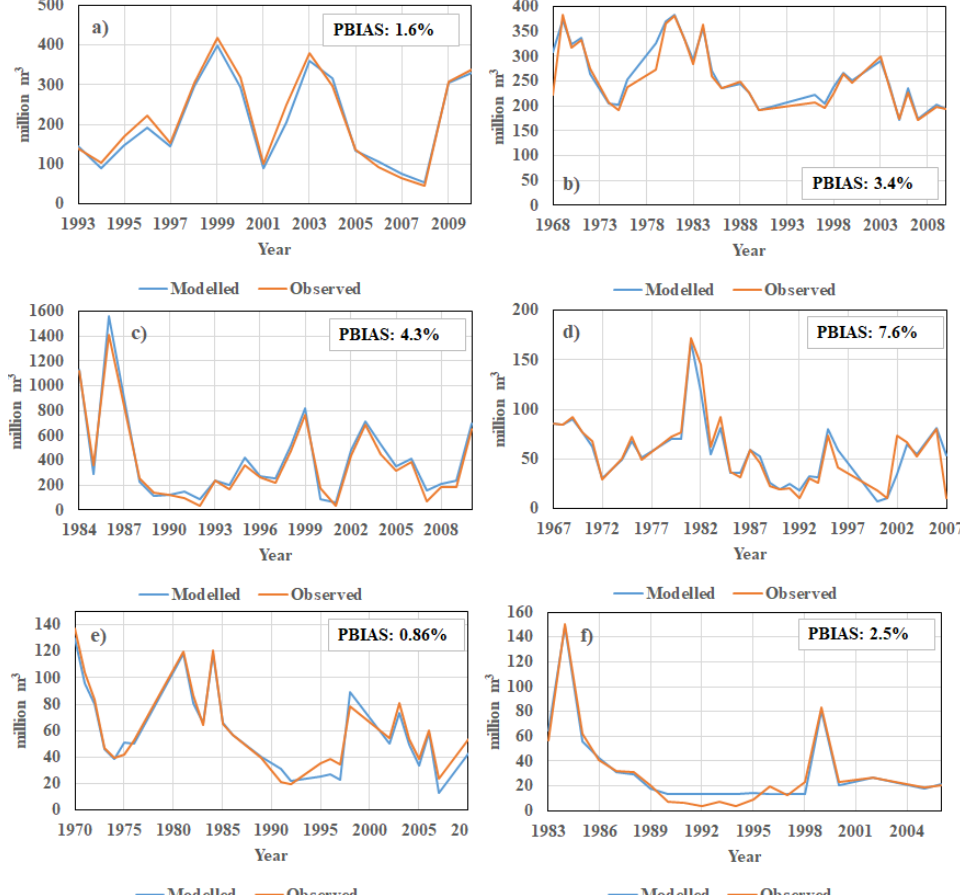
Figure 2. Calibration Results for the ( a ) Kufi; ( b ) Curusku; ( c ) Cine; ( d ) Ikizdere; ( e ) Dandalaz; and ( f ) Tavas Yenidere